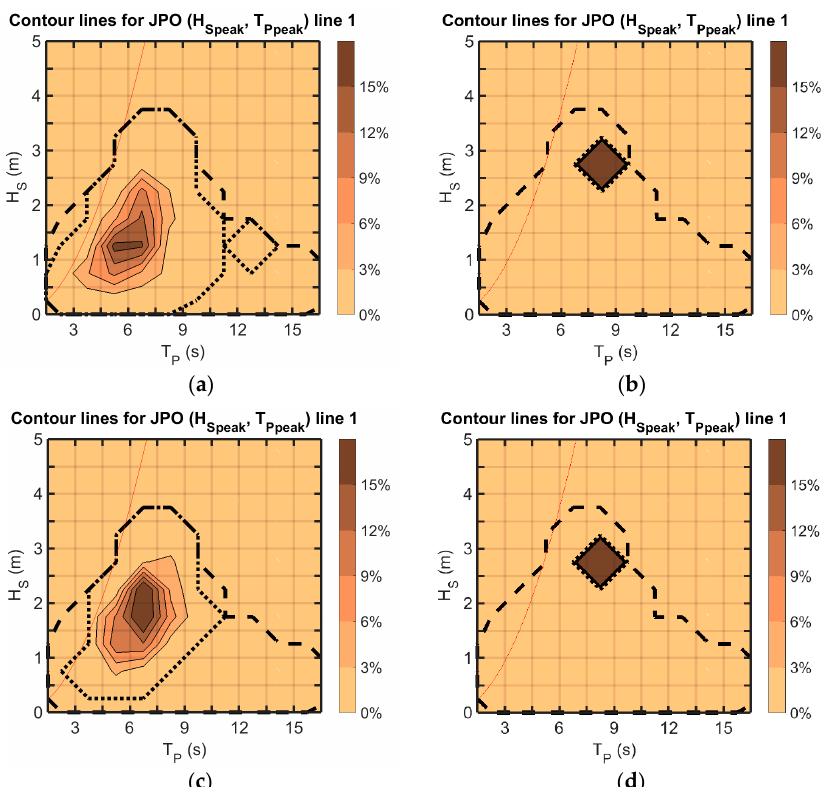
Figure 15. JPO for SWMTF environmental conditions associated with peak mooring loads: JPO ( H S peak , T P peak ) on mooring line 1, ( a ) with K = 5 and τ = 7.5 kN, ( b ) with K = 10 and τ = 7.5 kN, ( c ) with K = 5 and τ = 12.5 kN and ( d ) with K = 10 and τ = 12.5 kN. The large black dashed line is the external contour line of the general environmental conditions. The thin black dotted line is the external contour line of the environmental conditions associated with peak mooring load.